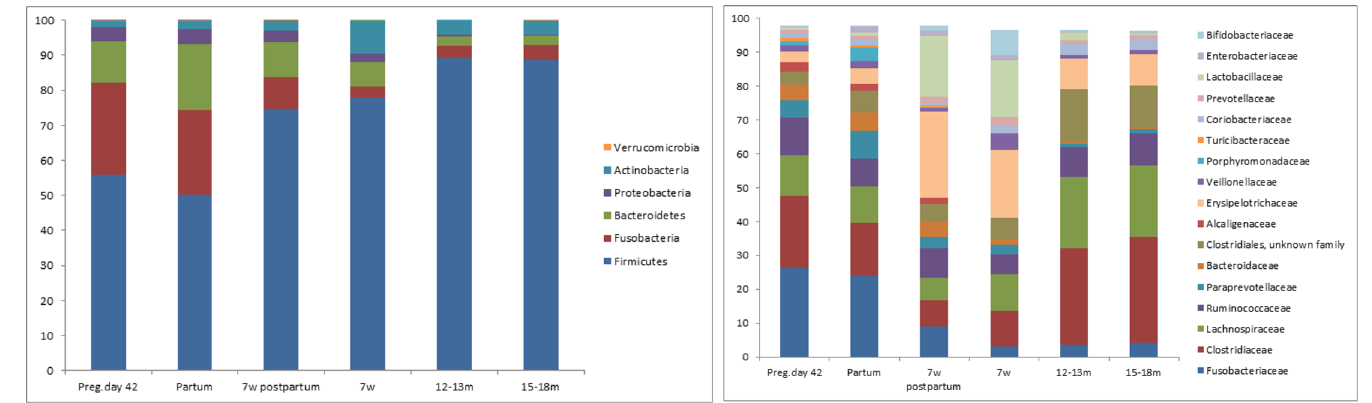
Fig 2. Relative abundance of bacteria phyla (a) and family (b) in feces from bitches at pregnancy day 42, partum and 7 weeks postpartum and from puppies at 7 weeks, 12–13 months and 15–18 months of age. Families with relative abundance > 1% are included.